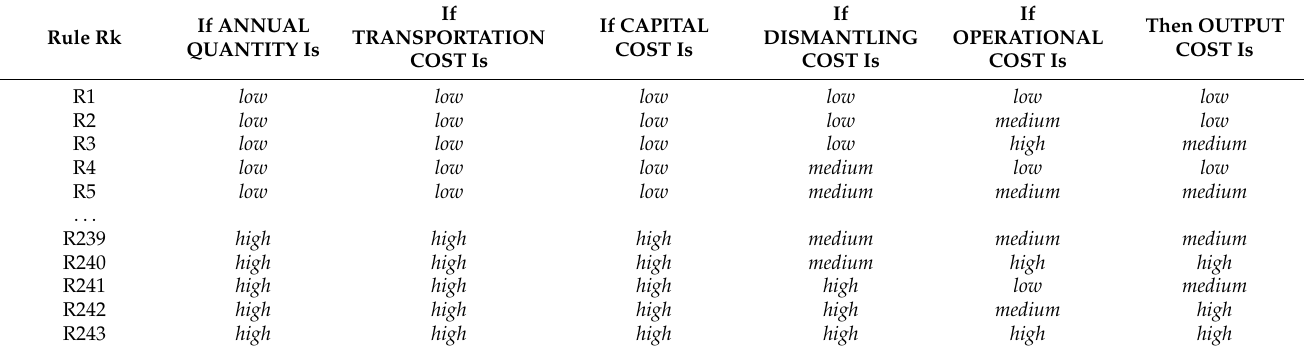
Table 6. CFRP recycling output cost